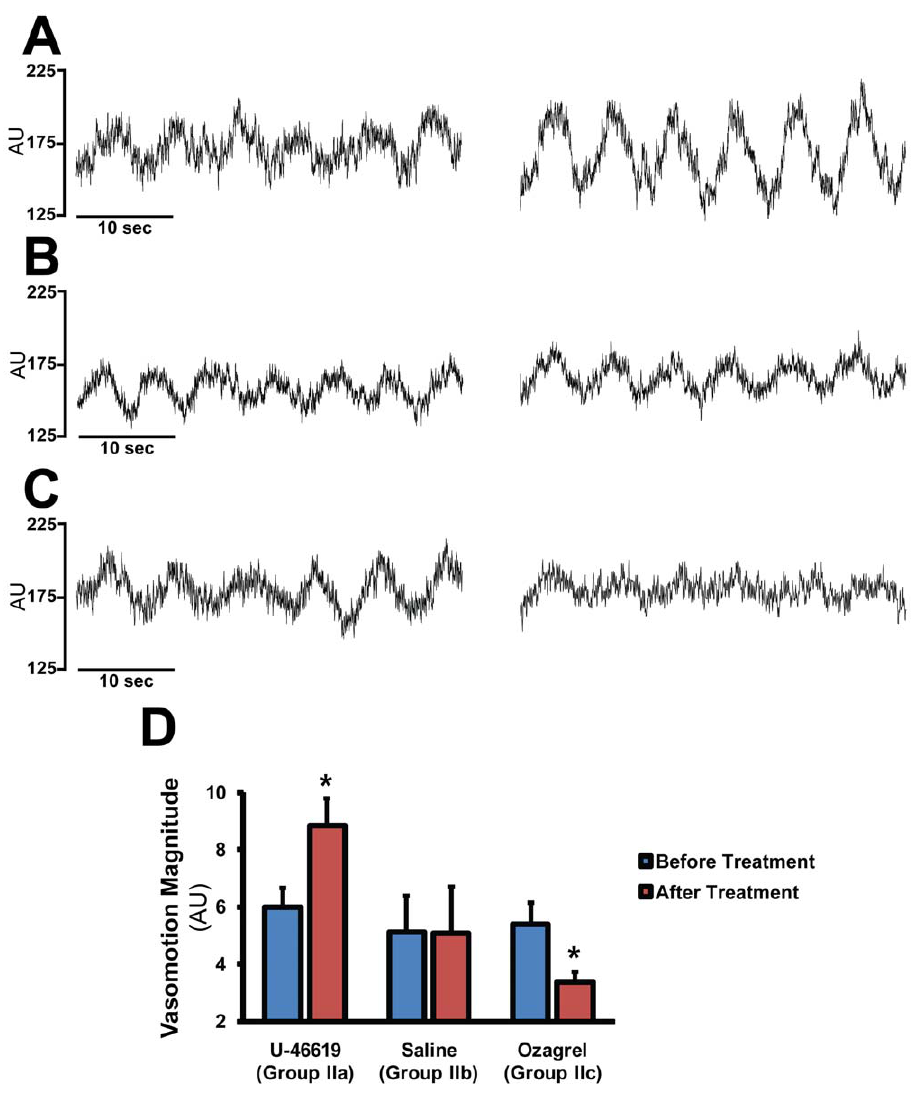
Figure 2. Weak activation of thromboxane receptors aggravates while inhibition of TXA 2 synthesis attenuates CoBF oscillations developed in the absence of NO. A–C : Original recordings of the cerebrocortical laser-Doppler flux in vivo before (left panels) and after (right panels) administration of the TP-receptor agonist U-46619 (A), the thromboxane synthase inhibitor ozagrel (C) or their vehicle (saline) (B) in rats pretreated by the NO synthase inhibitor L-NAME. D : Quantitative analysis of slow wave oscillations with discrete Fourier transformation. The peak magnitudes of the power spectra are compared before and after treatments in the three experimental groups. Values are mean 6 SEM (n=20, 12 and 14 in Group IIa, IIb, and IIc, respectively) *p , 0.05 vs. ‘‘Before